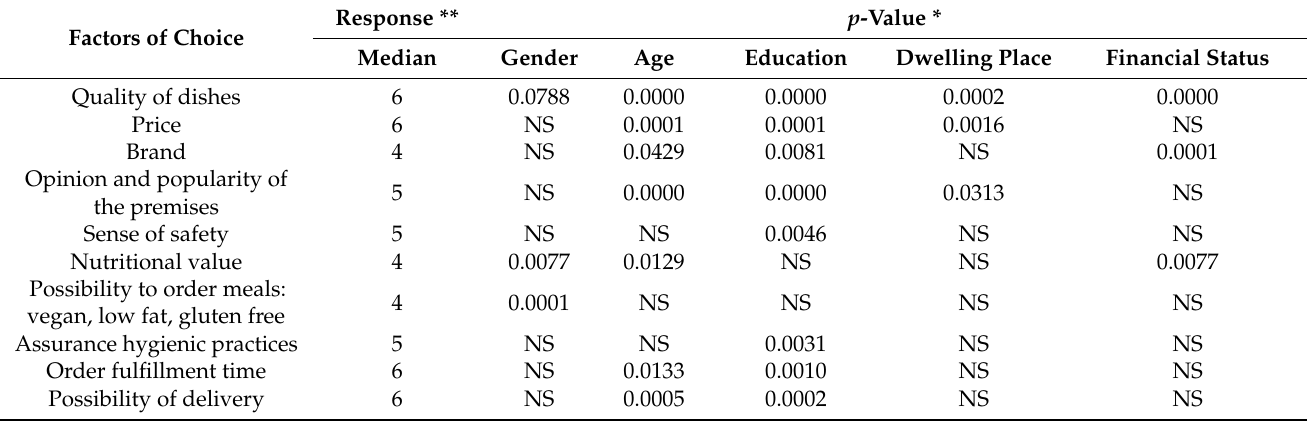
Table 4. Factors of catering establishments choice by respondents during a